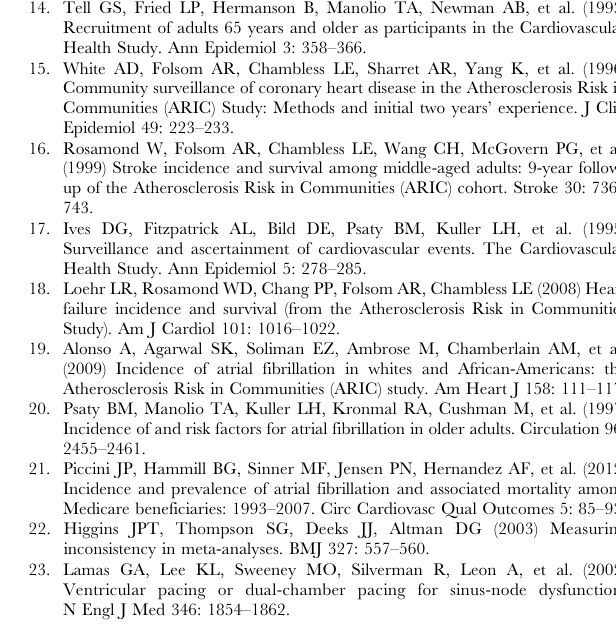
Table S1 Hazard ratios (95% confidence intervals) of mortality and selected cardiovascular diseases